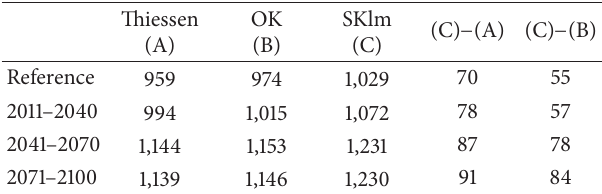
Table 6: Average rainfall from each spatial interpolation technique in the basin